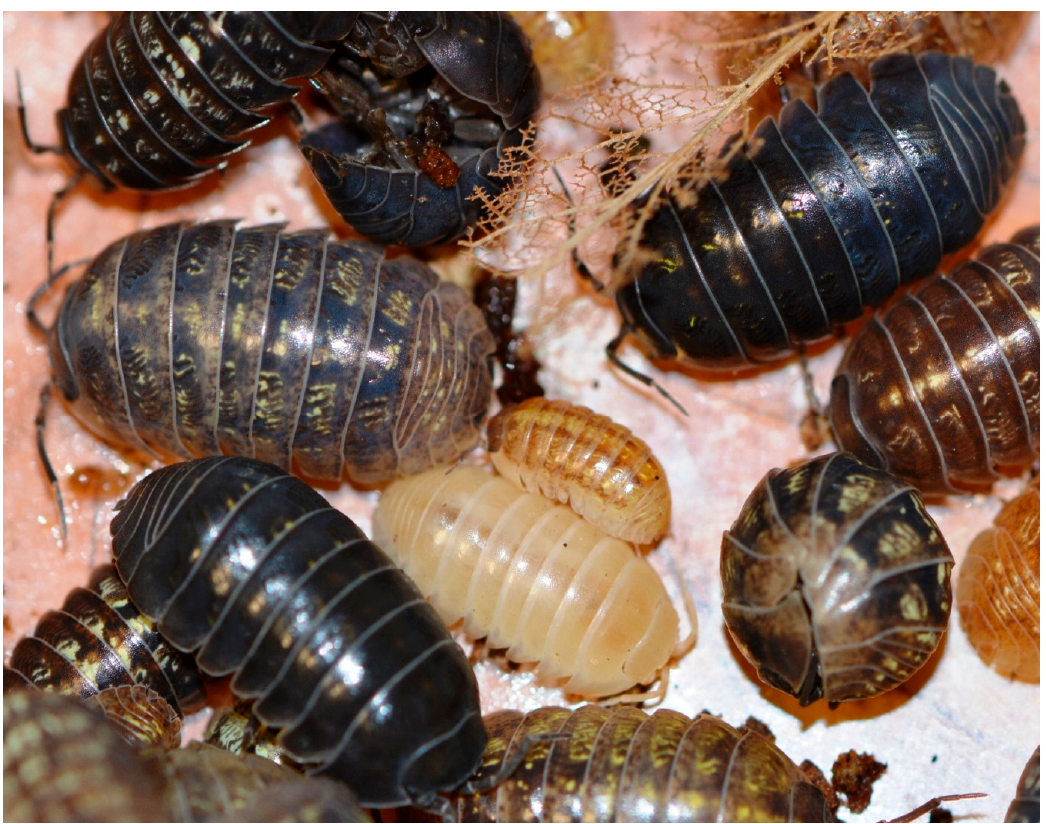
Figure 1. Photography of the common pill-bug Armadillidium vulgare (Crustacea, Isopoda, Oniscidea). Males and females are shown. Although quite variable, males tend to be darker than females (the white individual being an albino). Image courtesy of Isabelle Giraud.